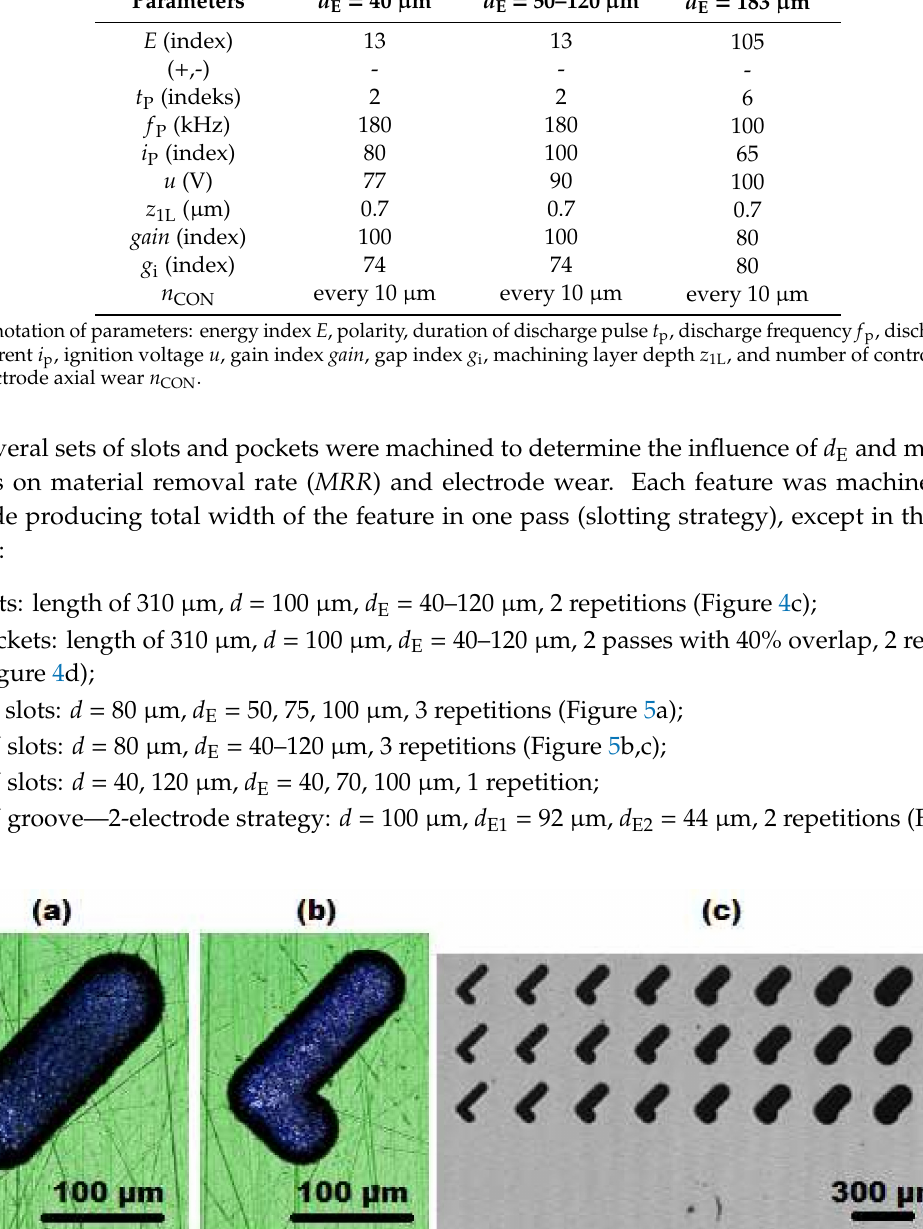
Table 2. Machining parameters setup particular to Sarix SX-200 EDM milling machine for corresponding d E . Parameters d E = 40 µ m